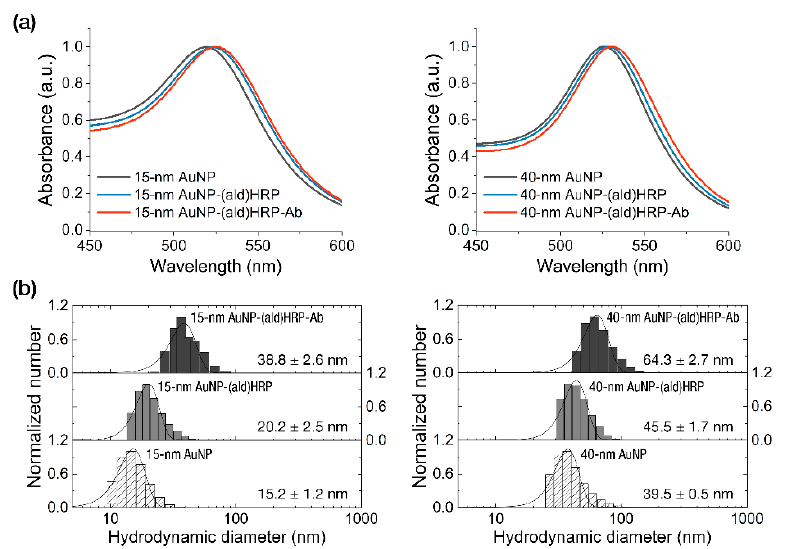
Figure 2. Characterization of the AuNP conjugates. ( a ) Analysis of the absorbance peak shift. ( b ) Analysis of the hydrodynamic diameters after each conjugate step.